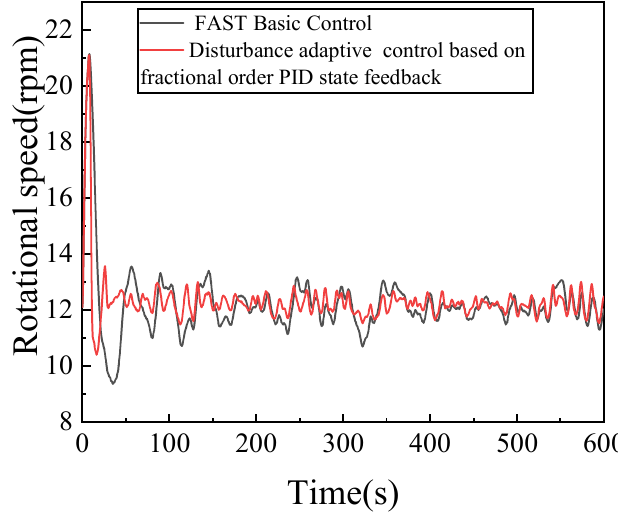
Figure 7. Comparison of rotor speed under two controls.